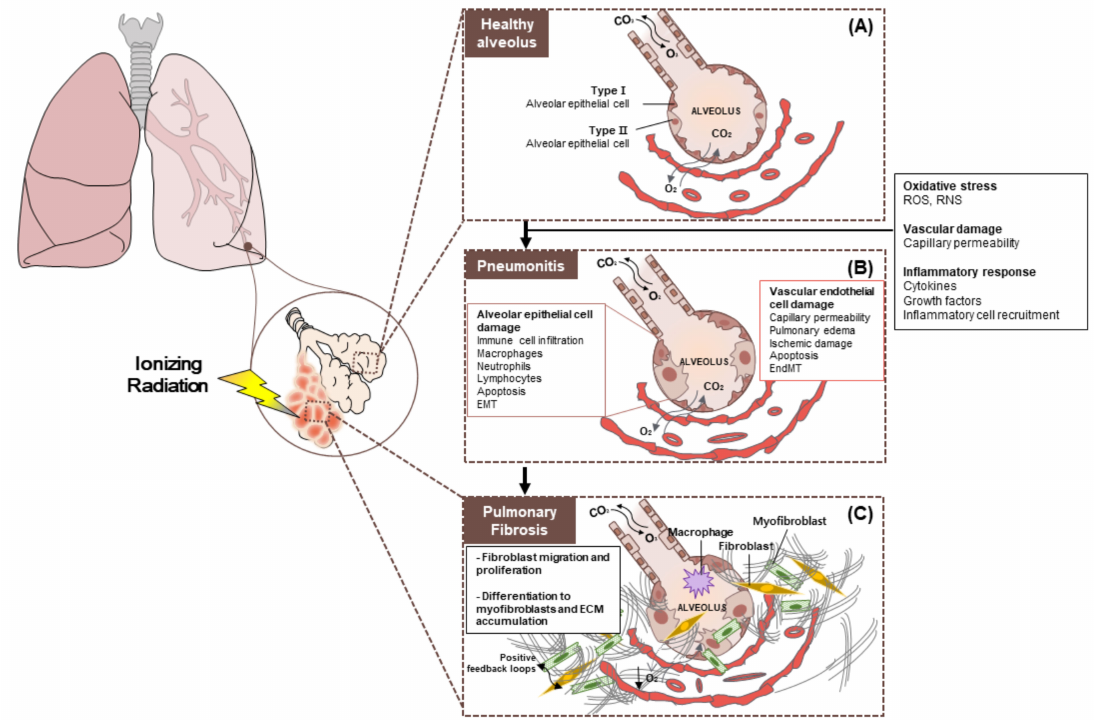
Figure 2. Pathobiology of radiation pneumonitis and radiation-induced lung injury. ( A ) Healthy alveolus. The epithelium, which is the outer layer of the alveoli, consists of two types of cells (type 1 and type 2 cells). Type 1 alveolar cells cover 95% of the alveolar surface and constitute an air-blood barrier. Type 2 alveolar cells are smaller and are responsible for the production of surfactants that coat the inside of each alveolus when inhaling and breathing. ( B ) Radiation pneumonitis is inflammation of the lungs caused by radiotherapy. Chronic pneumonitis can cause scarring of the lungs called pulmonary fibrosis. ( C ) Pulmonary fibrosis. General changes seen in interstitial lung disease. There is proliferation of interstitial fibroblasts and recruitment of fibrocytes into the interstitium (extracellular matrix (ECM)). These cells begin secreting components of the ECM such as collagen and other fibers. Cells also convert to myofibroblasts, which produce more ECM. Prolonged fibroblast activity leads to fibrosis, which is a hallmark of interstitial lung disease and restrictive lung patterns. Abbreviation: EMT: Epithelial to mesenchymal transition; EndMT: Endothelial to mesenchymal transition; ECM: Extracellular